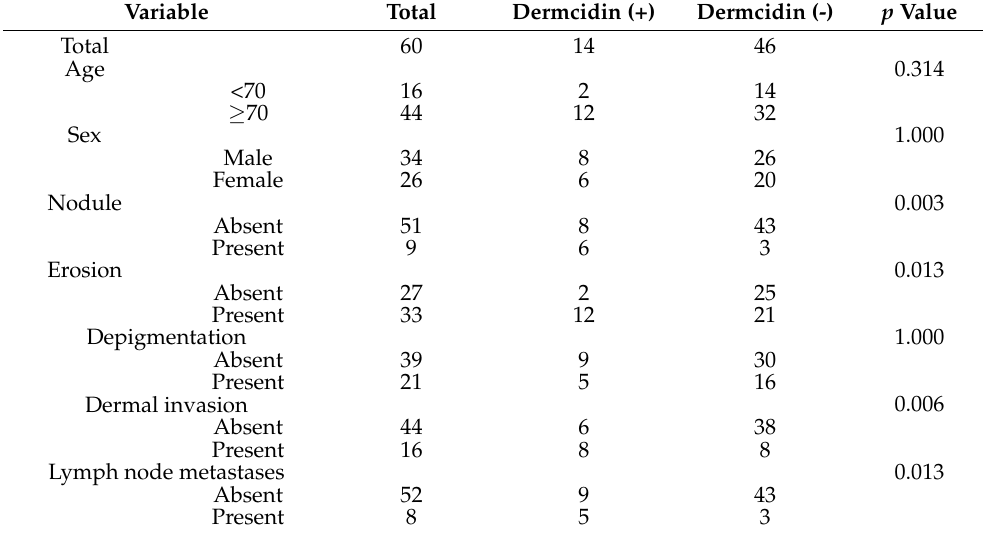
Table 2. Difference in clinical characteristics in dermcidin